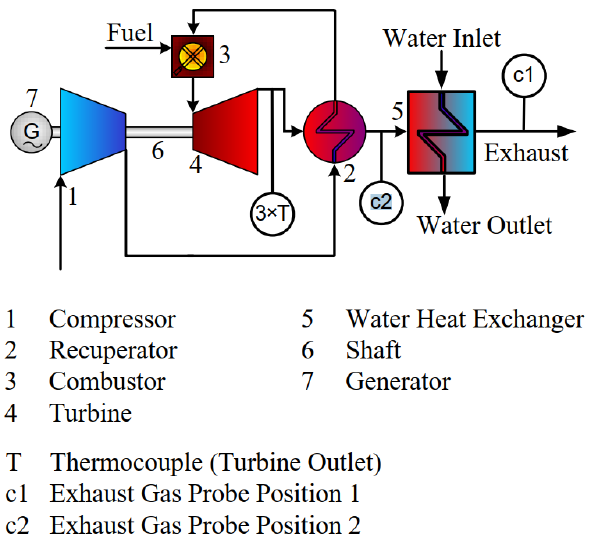
Figure 1. The micro gas turbine MTT Enertwin in its combined heat and power